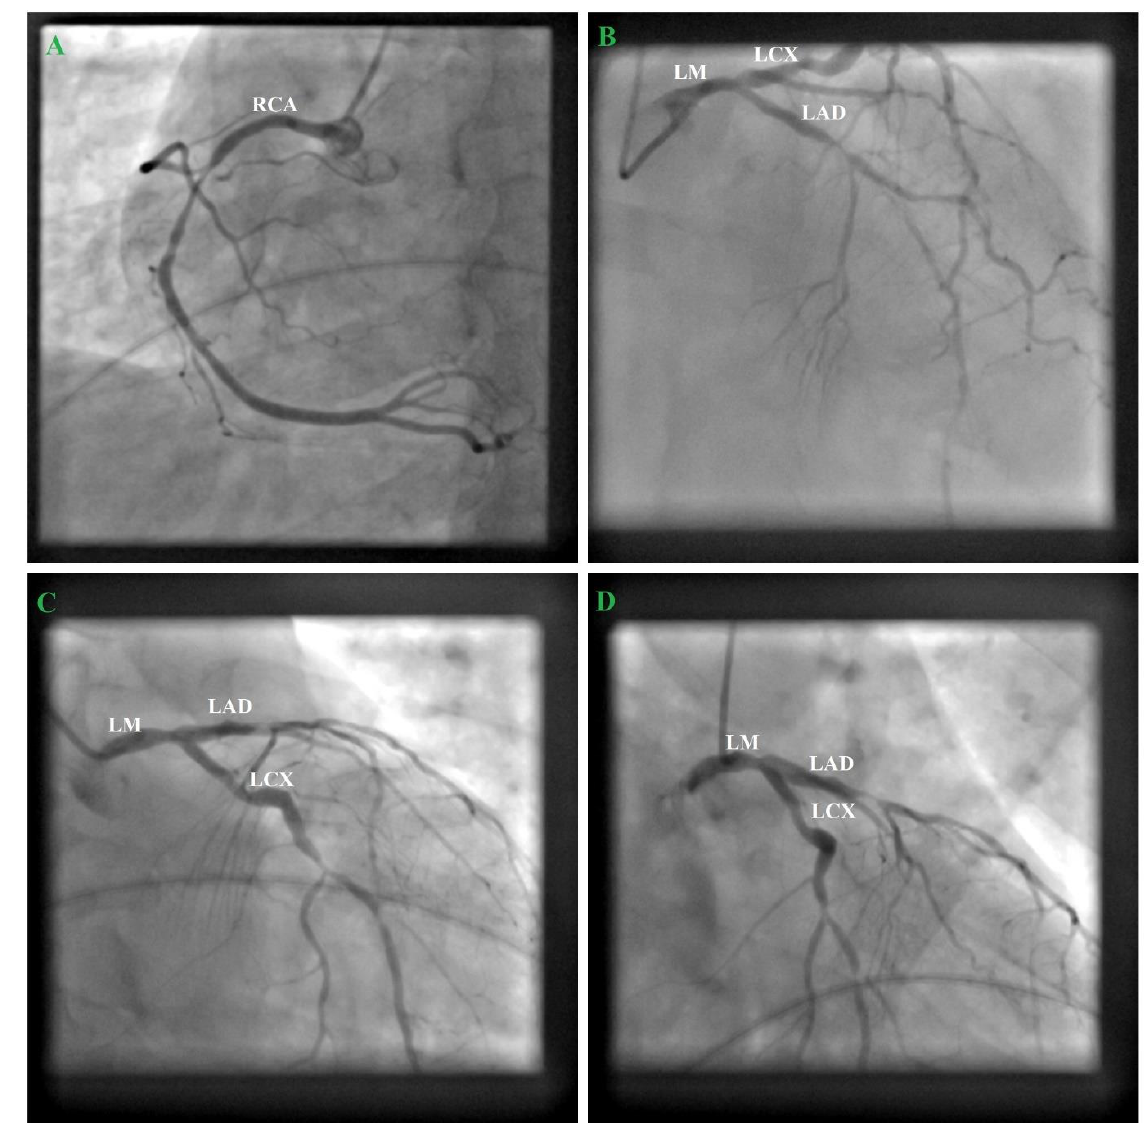
Figure 2. Coronary angiography . ( A ): Cranial projection of the right coronary artery (RCA) showing 90% stenosis in the mid segment of the RCA; ( B ): Cranial projection of the left coronary artery showing 90% stenosis in the proximal segment, a significant short obstructive lesion in the mid segment, and 60–70% stenosis in the distal segment of the left anterior descending artery (LAD); ( C , D ): Caudal projection of the left coronary artery showing a multiple 50–60% stenosis in the three segments of the left circumflex artery (LCX), 60–70% stenosis in the proximal segment of obtuse marginal 1 (OM1), and 50% stenosis in the distal segment of left main (LM).